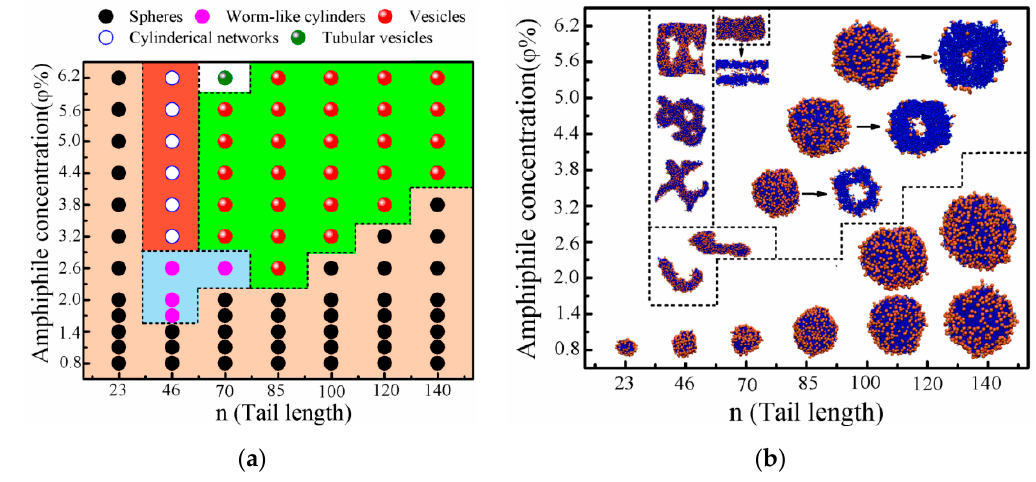
Figure 2. ( a ) Morphological phase diagram; and ( b ) typical snapshots of aggregates formed by the P n –H amphiphiles depending on ϕ and n at T ∗ = 1.4. The color scheme is the same as that in Figure 1. Each arrow points to the cross-section slice of the corresponding aggregate.